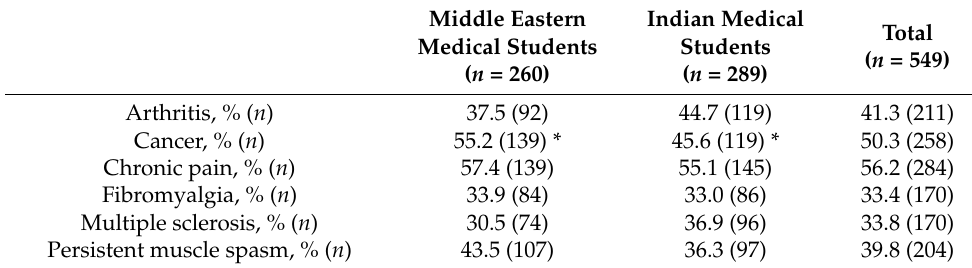
Table 2. Belief: medical cannabis effectiveness for pain-related